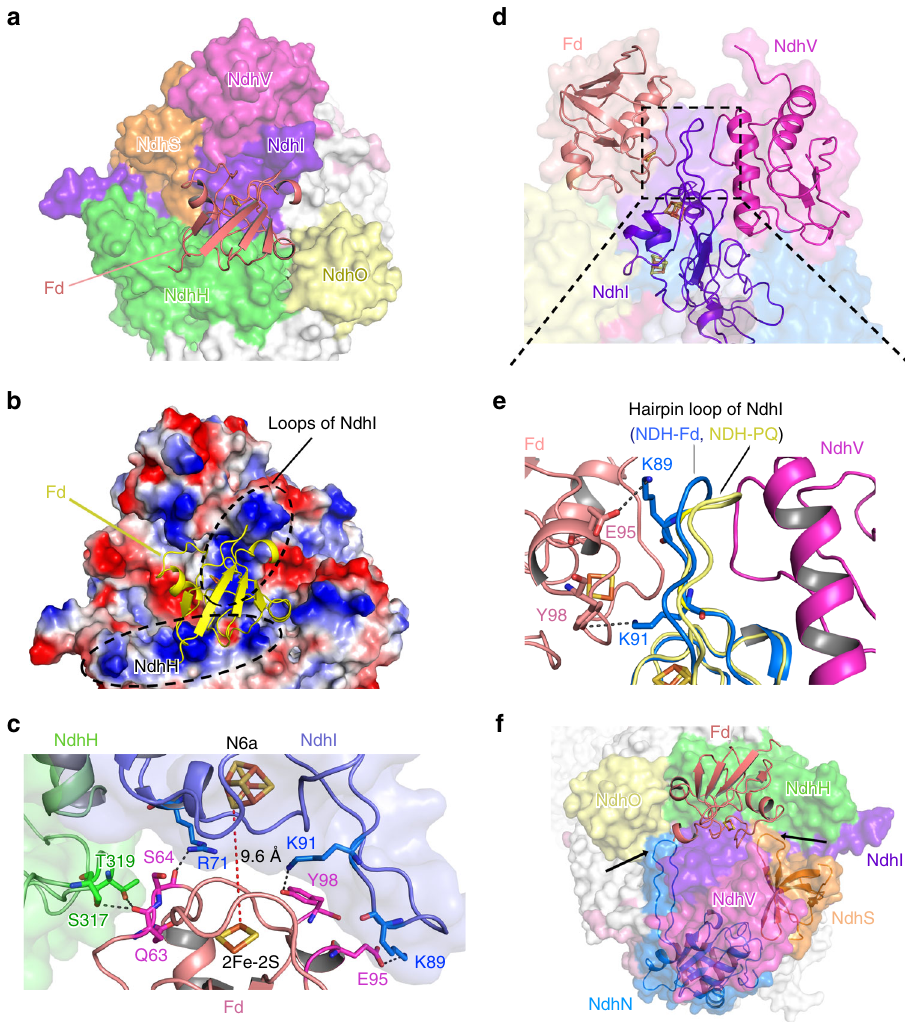
Fig. 4 The Fd binding pocket. a The Fd binding pocket is mainly formed by NdhI and NdhH. Fd is shown in cartoon, the NDH subunits are shown in surface mode. Subunits close to Fd are colored differently and other subunits are shown in white. b The electrostatic surface representation of Fd binding pocket. Red represents negative charge, and blue represents positive charge. Fd is shown as yellow cartoon. The positively-charged regions surrounding Fd are highlighted with black dashed circle and labeled. c The interactions between Fd and NdhI/NdhH subunits. The Fe – S clusters and the residues involved in the interactions between Fd and NdhI/NdhH are depicted as sticks and labeled. The hydrogen bonds are shown as black dashed lines. The distance between Fe – S clusters of NdhI and Fd (red dashed line) is indicated. d Fd and NdhV almost symmetrically bind the hairpin loop of NdhI from the opposite sides. The zoom-in view of the region circled by the black dashed line is shown in ( e ). e Superposition of NDH-Fd and NDH-PQ structures showing the different conformation of the hairpin loop in NdhI subunit. Two positively-charged Lys residues from the hairpin loop of NdhI are hydrogen bonded with residues from Fd. Residues involved in the interactions are shown as sticks and labeled. f The loop regions in NdhN and NdhS (pointed with black arrows) interact with NdhI and/or NdhH and help to stabilize the Fd binding